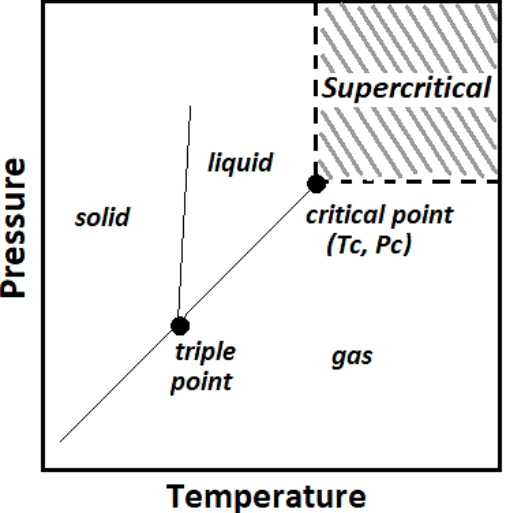
Figure 1. Sketch of the phase diagram of a pure substance.